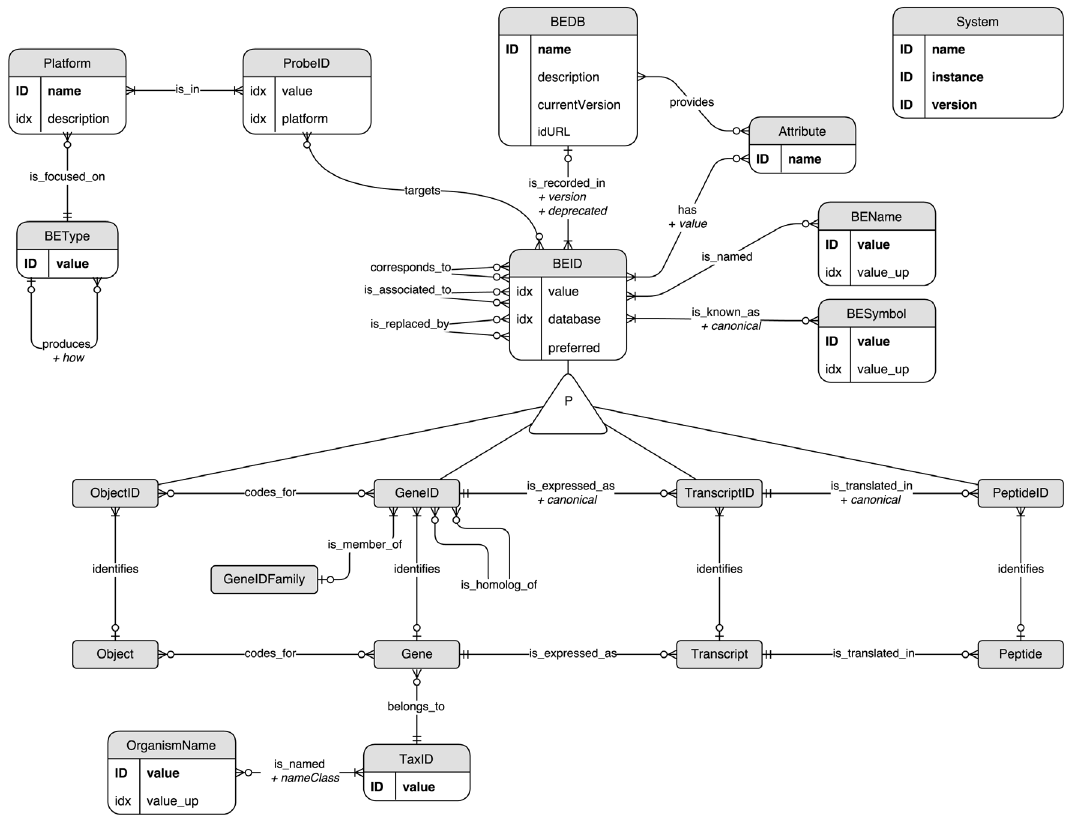
Figure 1. The BED graph data model. The model is shown as an Entity/Relationship (ER) diagram: entities correspond to graph nodes and relationships to graph edges. “ID” and “idx” indicate if the corresponding entity property is unique or indexed respectively. Some redundancies occur in this data model. Indeed some “value” properties are duplicated in upper case (“value_up”) in order to improve the performance of case-insensitive searches. Also, the database of a BEID node is provided as a property to ensure uniqueness of the couples of “database” and “value” properties. The same approach has been applied for the “platform” property of ProbeID